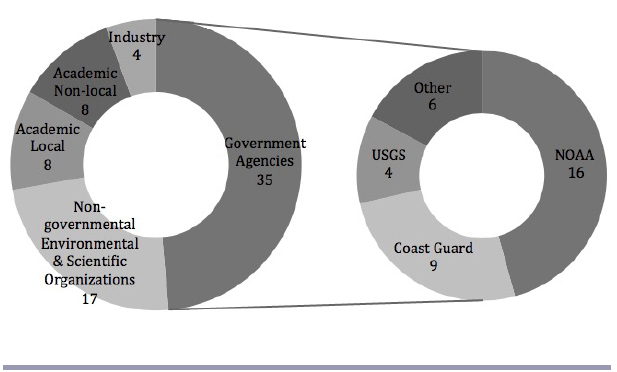
Fig. 2 . The number of interviewees across each target stakeholder group: government; nongovernmental environmental organizations, including independent research institutions, advocacy NGOs, and consultants; local academics, working at an academic institution in the Gulf of Mexico; nonlocal academics; and industry. The second annulus graph represents a breakdown of the 35 interviewees working in federal government agencies.